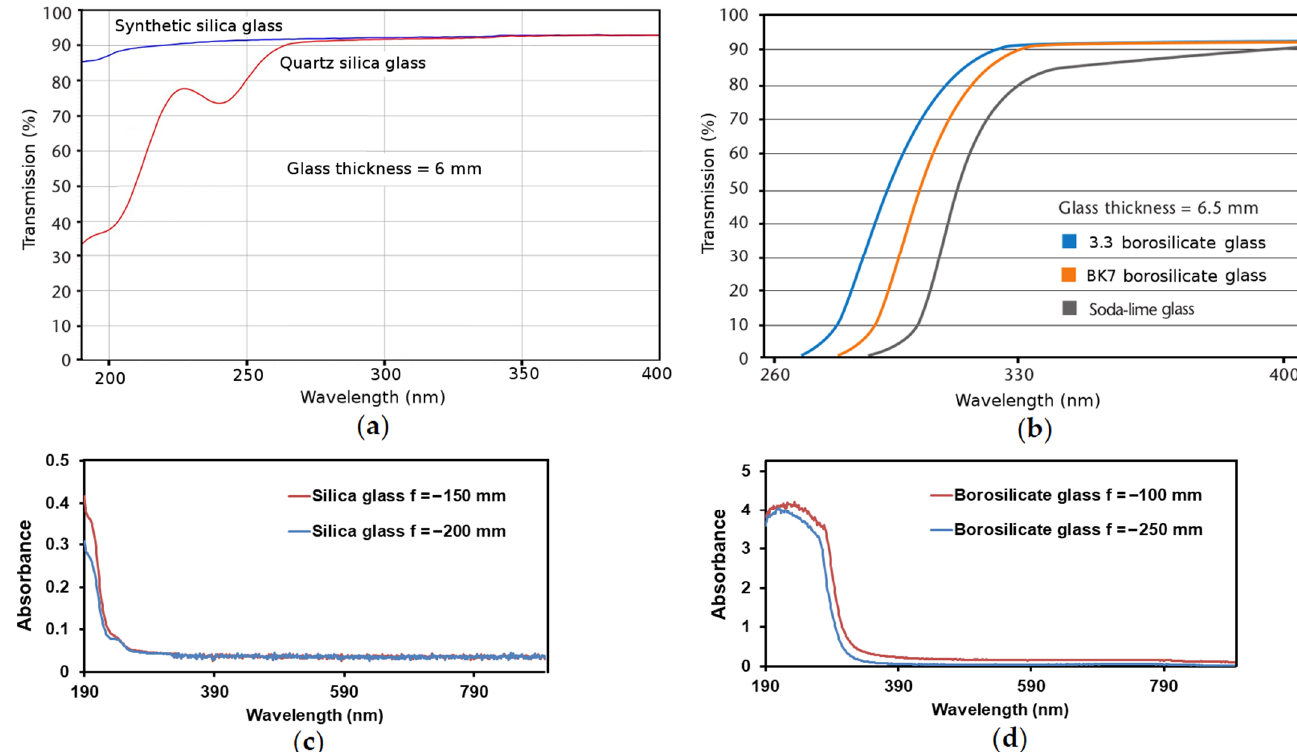
Figure 10. UV–visible spectra: ( a ) standard spectra for natural silica glass and synthetic silica glass; ( b ) Standard spectra for borosilicate glasses and soda-lime glass; ( c ) obtained UV–visible spectra in silica glass lenses of different focal length; ( d ) obtained UV–visible spectra in borosilicate glass lenses of different focal length.